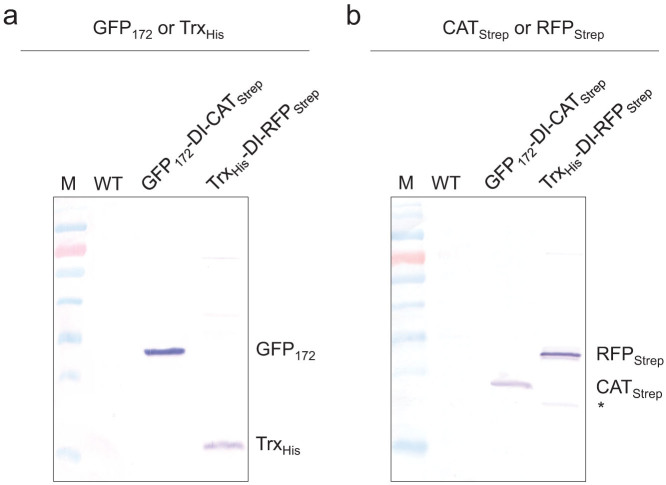
DI polyprotein system is also applicable to co-expressing proteins other than fluorescent reporters.Efficient release of protein constituents from GFP172-DI-CATStrep and TrxHis6-DI-RFPStrep polyproteins was detected using (a) anti-His tag, and (b) anti-Strep tag western blots.